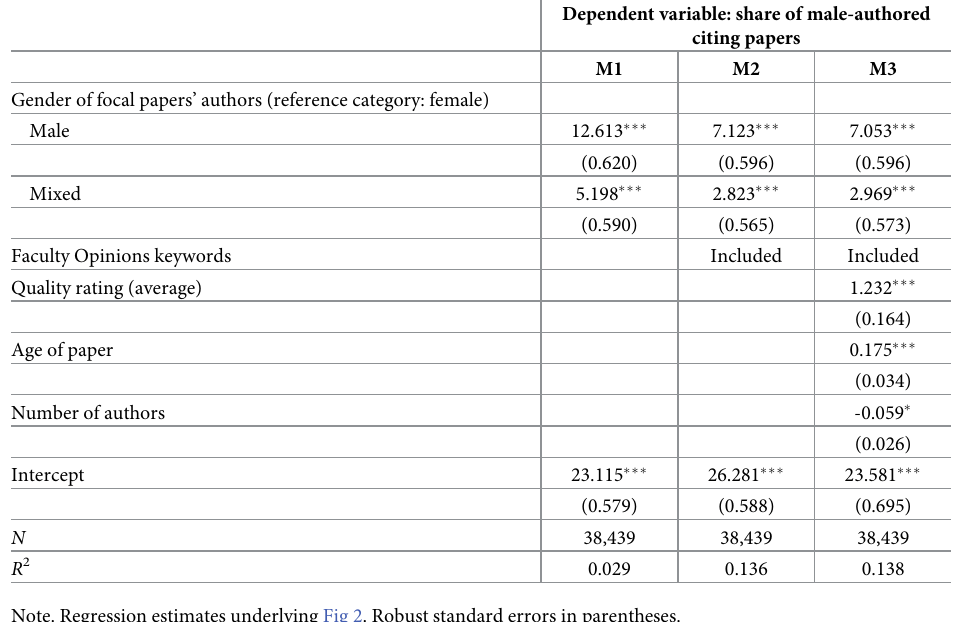
Dependent variable: share of male-authored citing papers M3